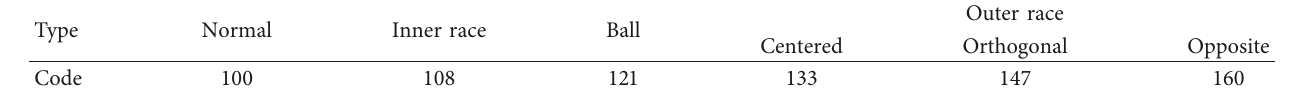
Table 1: Types and codes of the